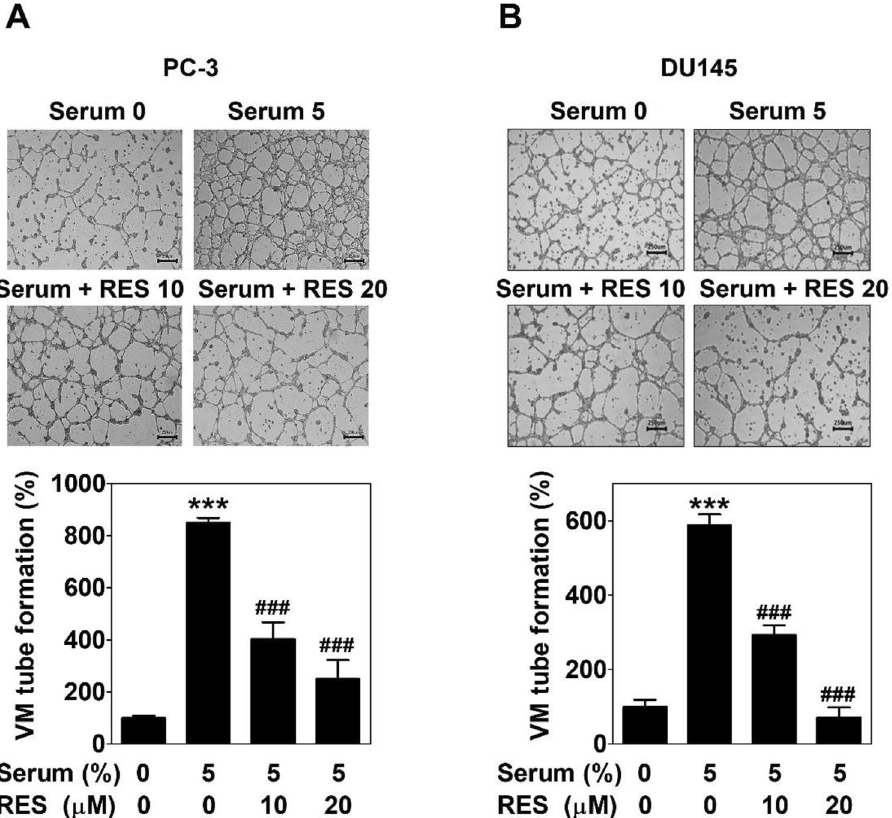
Figure 3. Resveratrol decreases serum-induced VM tube formation in prostate cancer cells. PC-3 ( A ) or DU145 cells ( B ) were seeded on a matrigel-coated a 24-well plate and treated with serum with or without RES. After a 16 h-incubation, the images were taken with an inverted microscope at 40 × magnification. Scale bar = 250 μm. The number of VM tube formation was counted and expressed as a percentage of the untreated control group. Data present as the mean ± SD of three independent experiments by analysis of Student’s t- test. *** p < 0.001 versus untreated control; ### p < 0.001 versus serum-treated